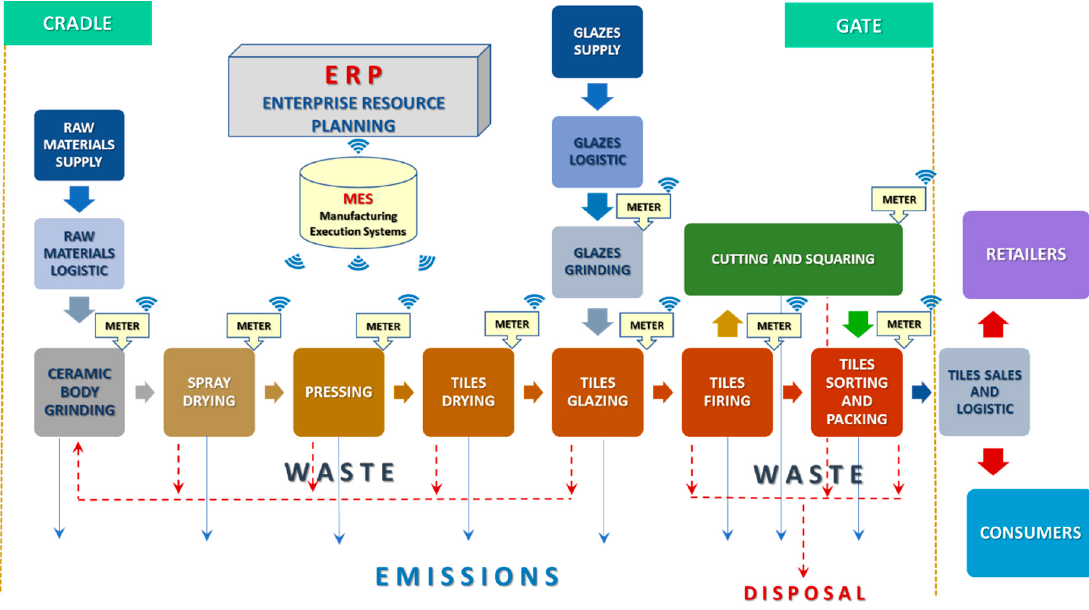
Figure 4. Monitoring of manufacturing data in an IoT environment.